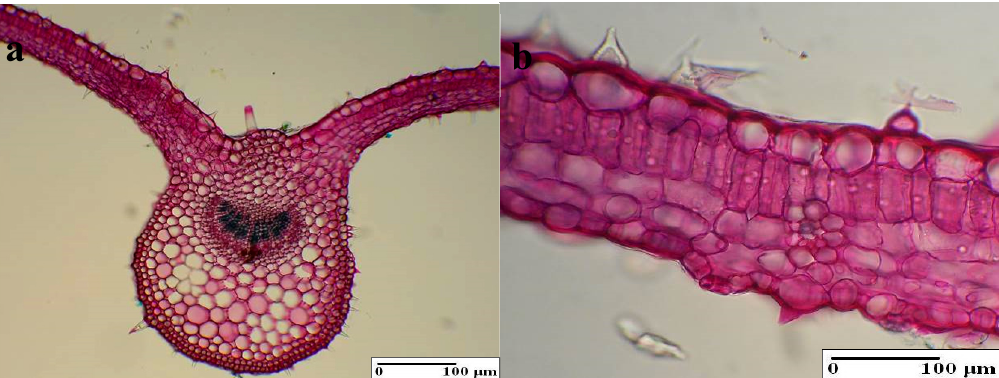
Figure 7. The internal structure of the leaf: ( a ) general aspect (BBPE 1), ( b ) mesophyl with secretory hairs (BBPE 1).